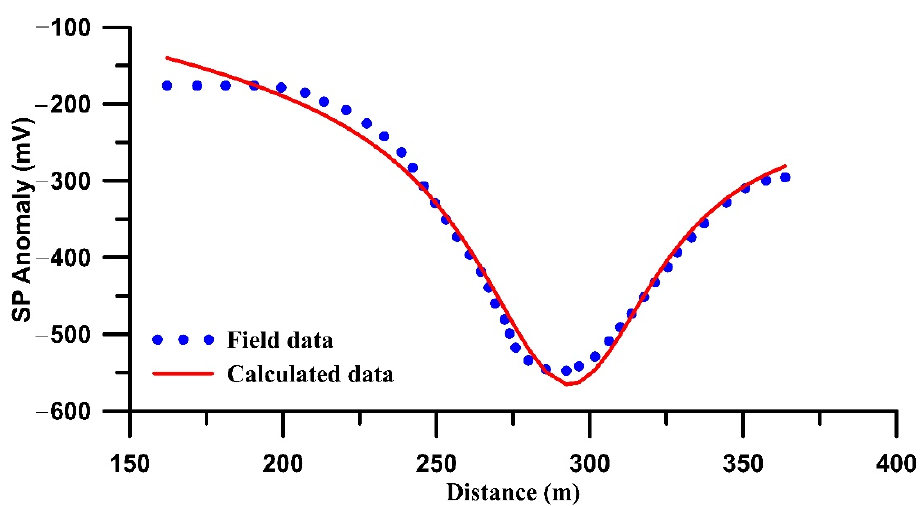
Figure 11. Fits for field data of Filizchai polymetallic deposit, Southern Greater Caucasus, Azerbaijan.